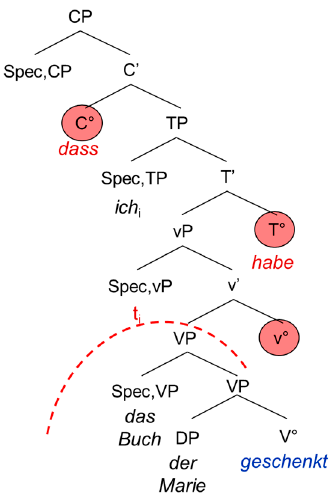
Figure 3. Structure of the German main clause.